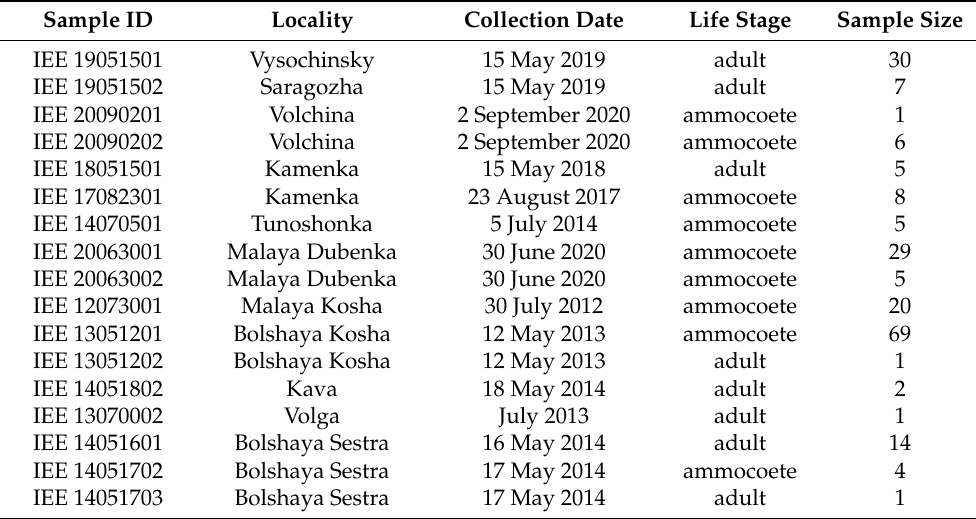
Table 1. Samples, used in the paper, and their